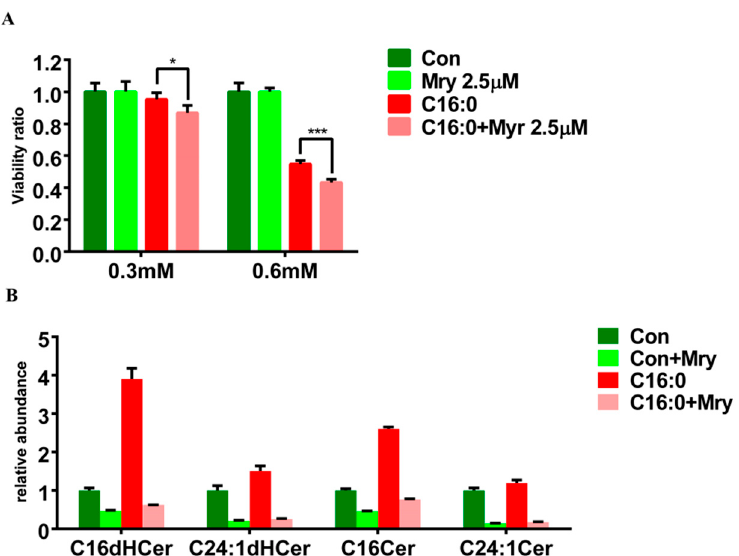
Figure 6. Metabolic pathways of and dynamic changes in lipid classes in HepG2 cells incubated for 4, 8, and 16 h with 0.3 mM 13 C16-palmitoleic acid. The cellular abundances of metabolites labeled with the stable isotope were marked as blue (M* + 16), red (M* + 32), and green (M* + 48) bar charts. (mean ± SD, n = 18, triplicates).